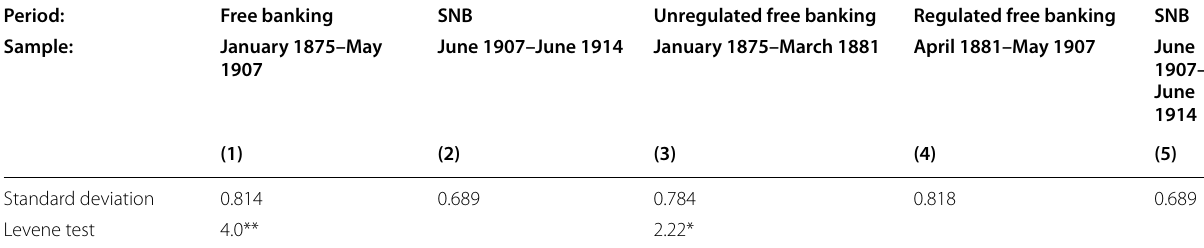
Table 3 Analysis of variance (ANOVA) of the discount-rate in Switzerland (1872–1914)